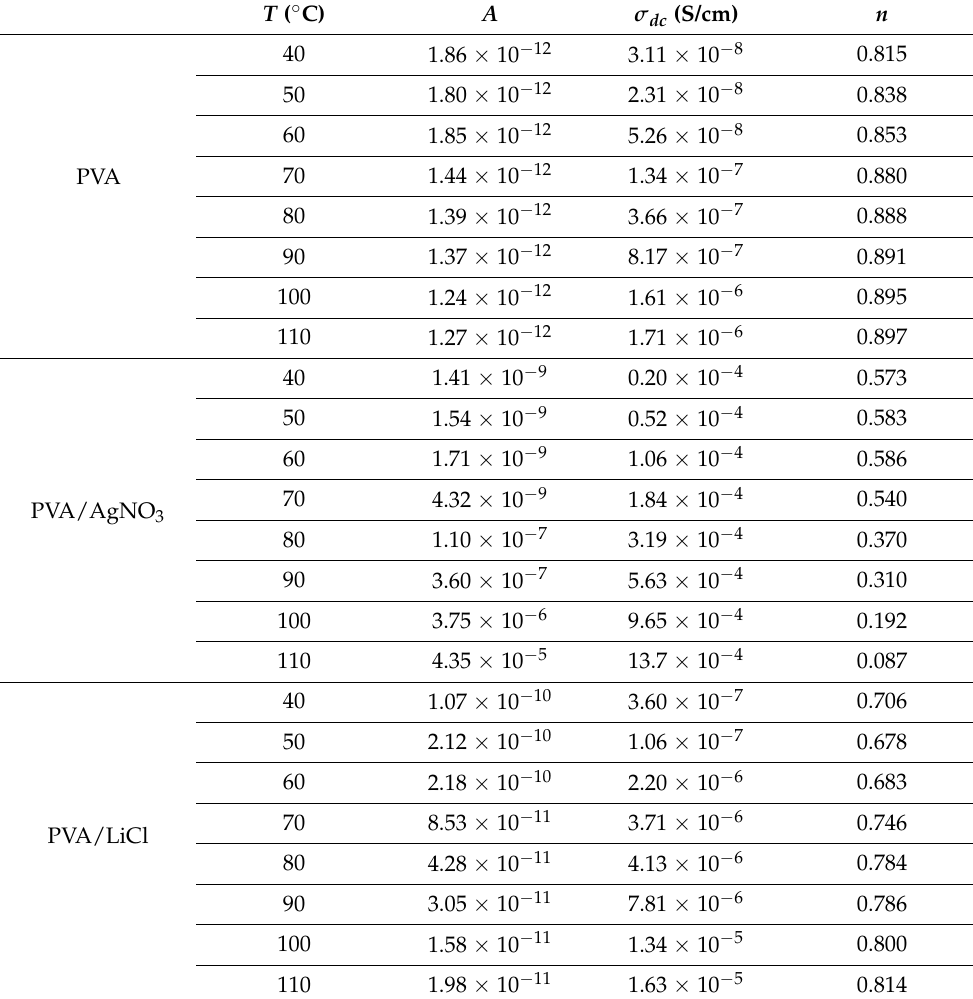
Table 2. Extracted parameters ( σ dc , ω h and n ) at different temperatures as predicted from the fitting of the ac conductivity data for pure and doped PVA